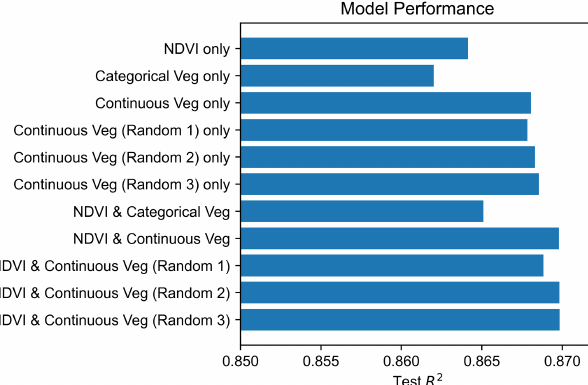
Figure A4. Random forest model performance for model runs us- ing various combinations of vegetation features. The categorical vegetation uses the vegetation types shown in Fig. 4. The contin- uous vegetation is a ranking ordered by which vegetation type has higher SWE. The continuous vegetation ranking is also randomized in three different ways to determine if the ranking order is impor- tant.